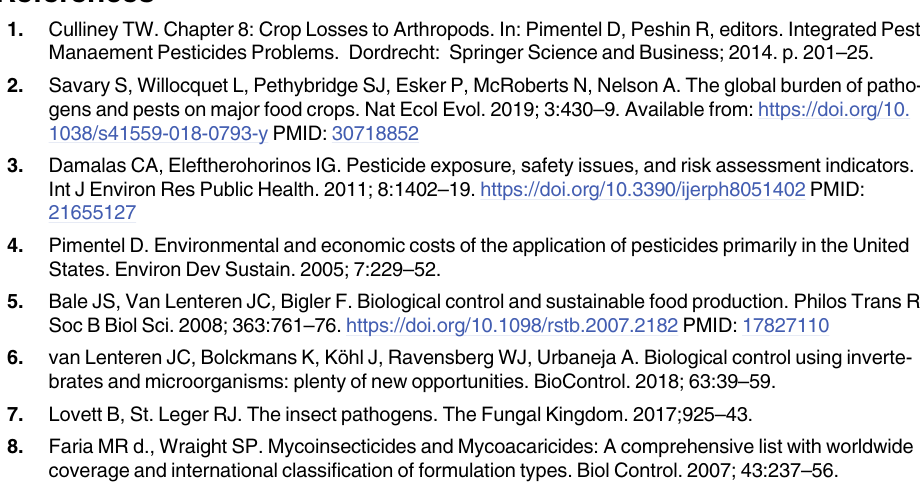
S1 Table. Results of PCR detection of inoculated fungi in sweet pepper plants 1 .